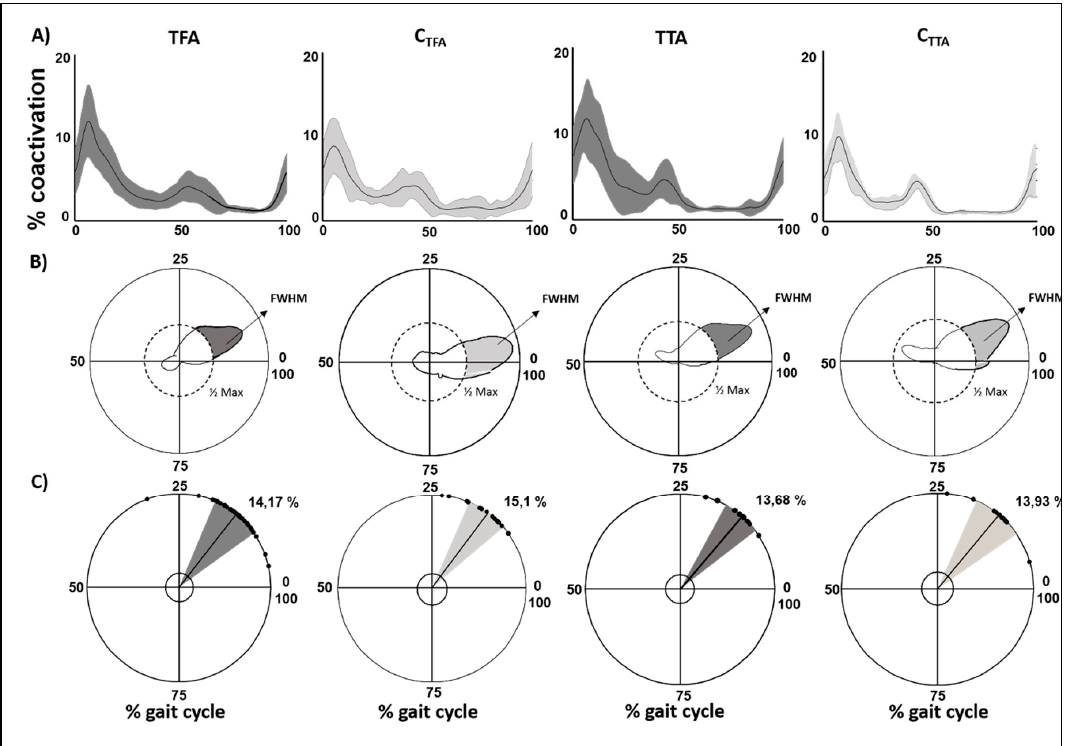
Figure 2. ( A ) Time-varying multimuscle coactivation function (TMCf) curves shown as mean curves with standard deviations for people with transfemoral amputation (TFA), the control group matched with TFA (C TFA ), for people with transtibial amputation (TTA), and the control group matched with TTA (C TTA ). ( B ) Full width at half maximum (FWHM) of the TMCf for each group shown in polar coordinates. ( C ) Center of activity (CoA) of the TMCf for each group: each dot represents the mean CoA value of a subject, whereas the solid line and the width of the circular sector represent the mean and standard deviation values of the CoA of all subjects, respectively. All parameters are shown as percentages of the gait cycle.